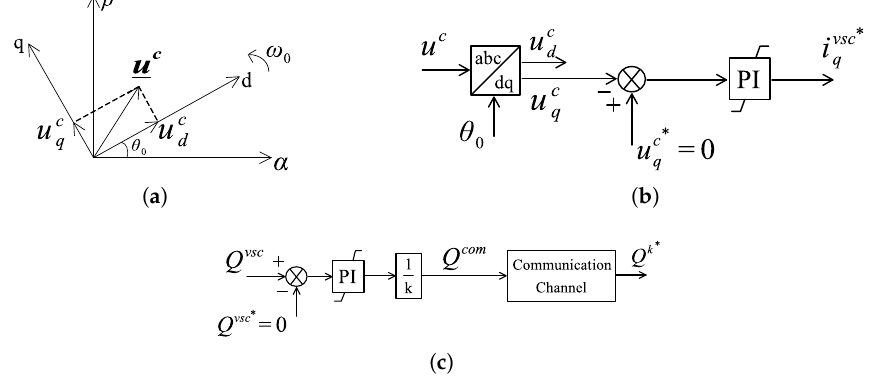
Figure 4. Centralised frequency control: ( a ) vector diagram in the stationary and the synchronous reference frames; ( b ) the frequency control (FC) scheme; ( c ) wind turbines’ (WTs’) reactive power reference